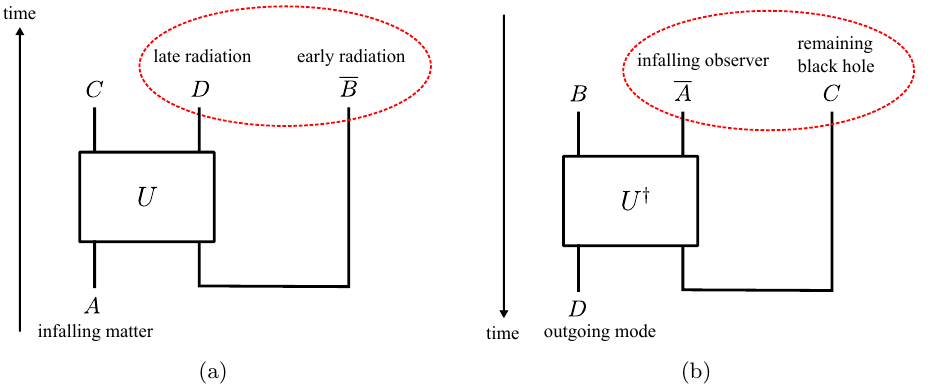
Figure 4 . (a) The Hayden-Preskill recovery problem. (b) The interior reconstruction problem. interior reconstruction problem, D , C , and A play roles of the infalling quantum state, the early radiation, and the late radiation in the Hayden-Preskill problem respectively ((cid:12)gure